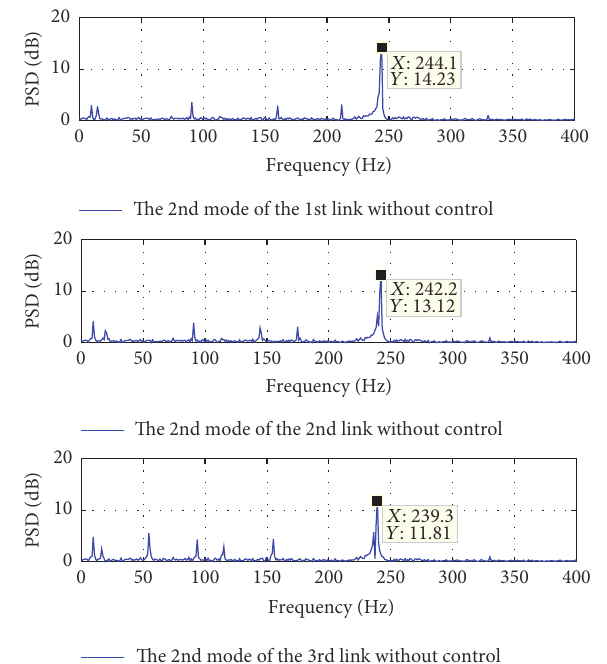
Figure 15: The PSD plot of the second mode of the three links without control.